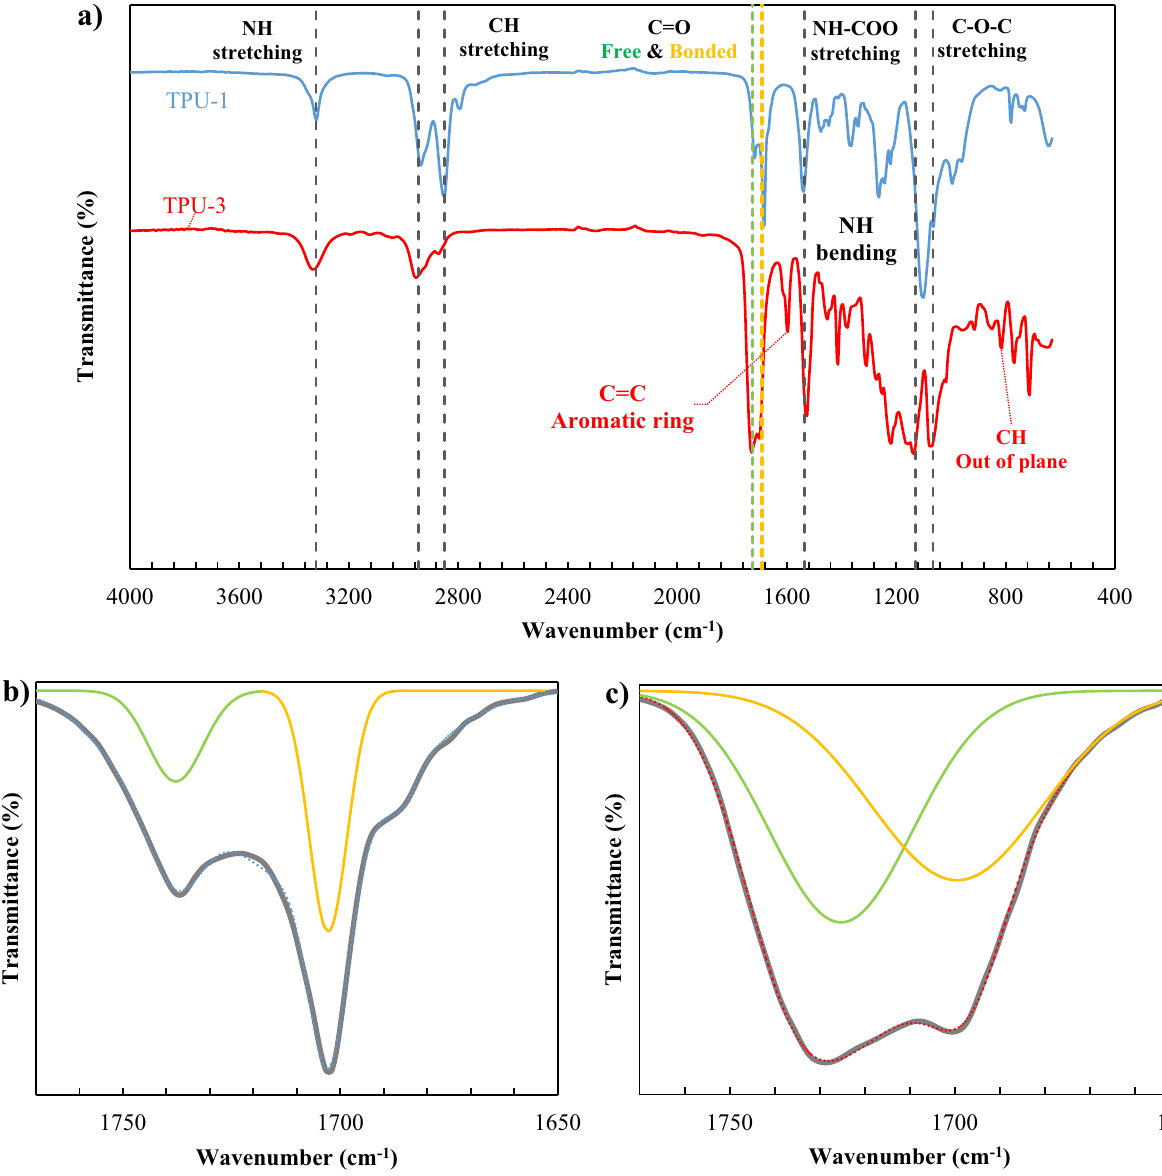
Figure 3. The FTIR spectra of: ( a ) TPU-1 (blue line) and TPU-3 (red-line), and peak analysis around C=O vibration for: ( b ) TPU-1, and ( c ) TPU-3.